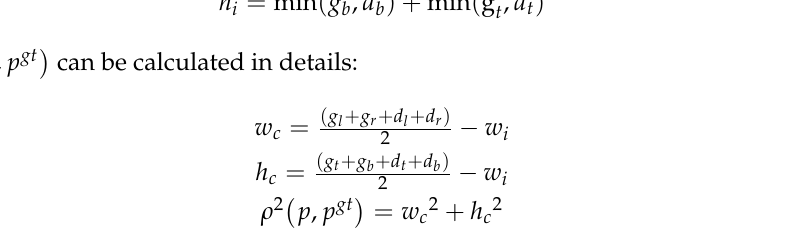
Figure 4. The distance of central points and diagonal